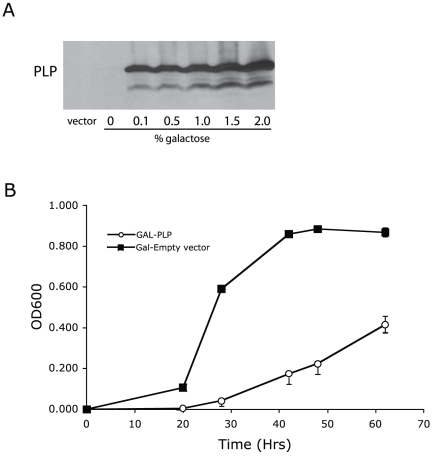
SARS-CoV PLP produces a slow growth phenotype in yeast.A. Galactose induction of SARS-CoV PLP. Strain containing HA tagged PLP under the control of the yeast GAL1 promoter was grown in the presence of 0 to 2% galactose. Protein was extracted and analyzed by anti-HA western blot. B. Growth curve of yeast expressing either empty vector or HA tagged PLP grown in 2% galactose media.